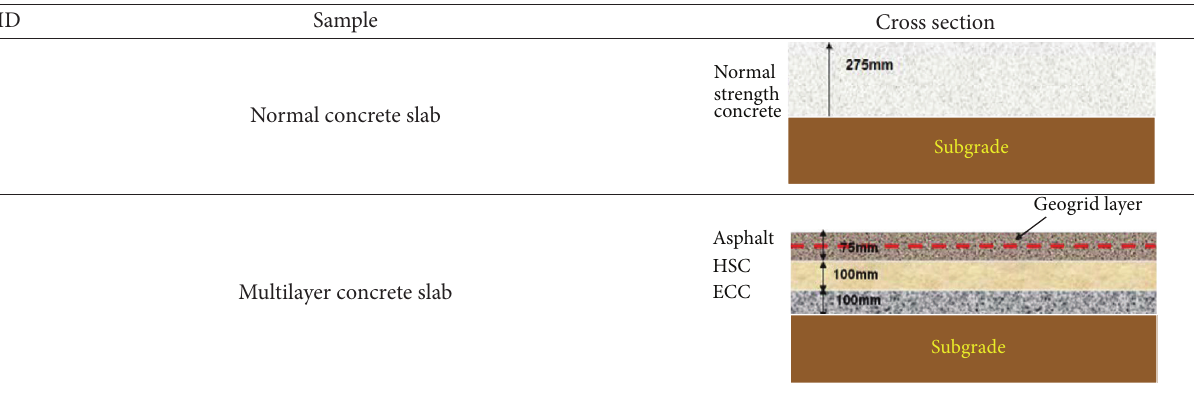
Table 1: Cross section of pavement slabs tested in field blast tests